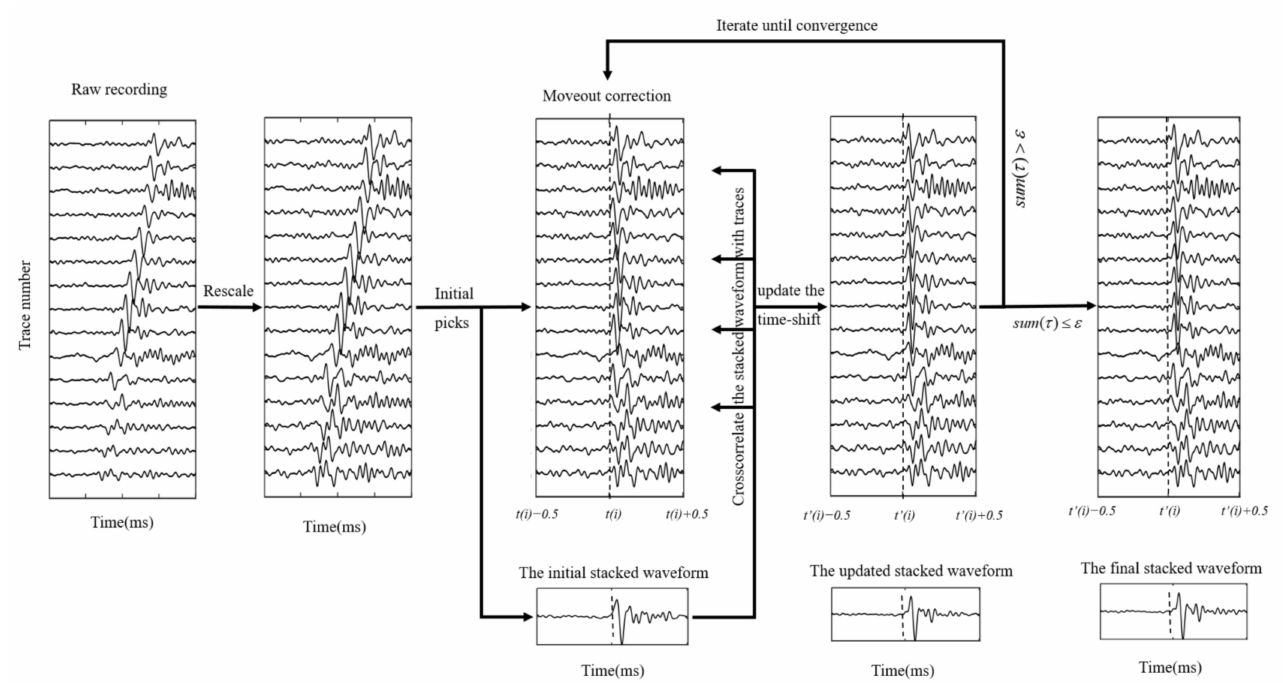
Figure 2. Iterative cross-correlation based workflow for refining arrival